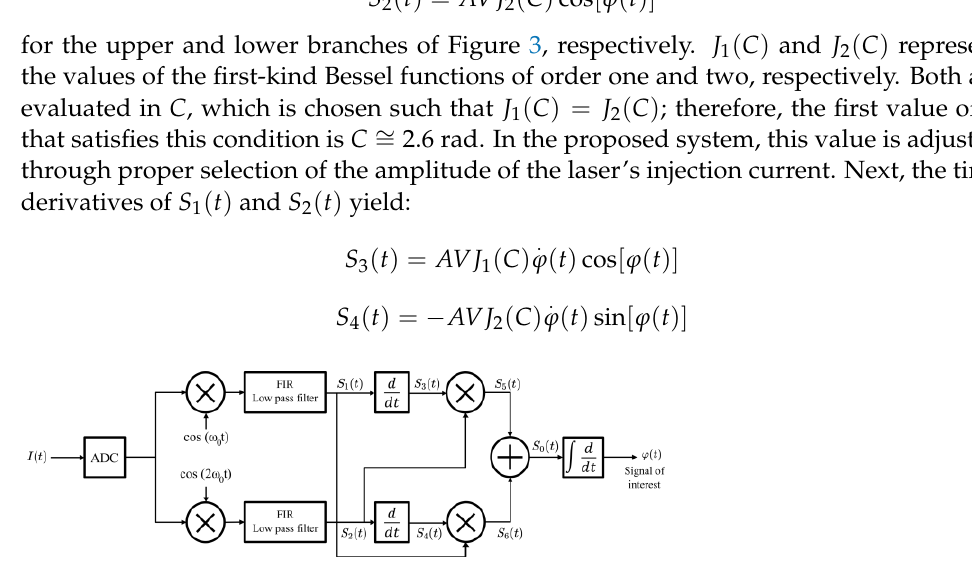
Figure 3. Block diagram of the homodyne interferometric demodulation scheme, Equations (4) to (11), as implemented on the FPGA.